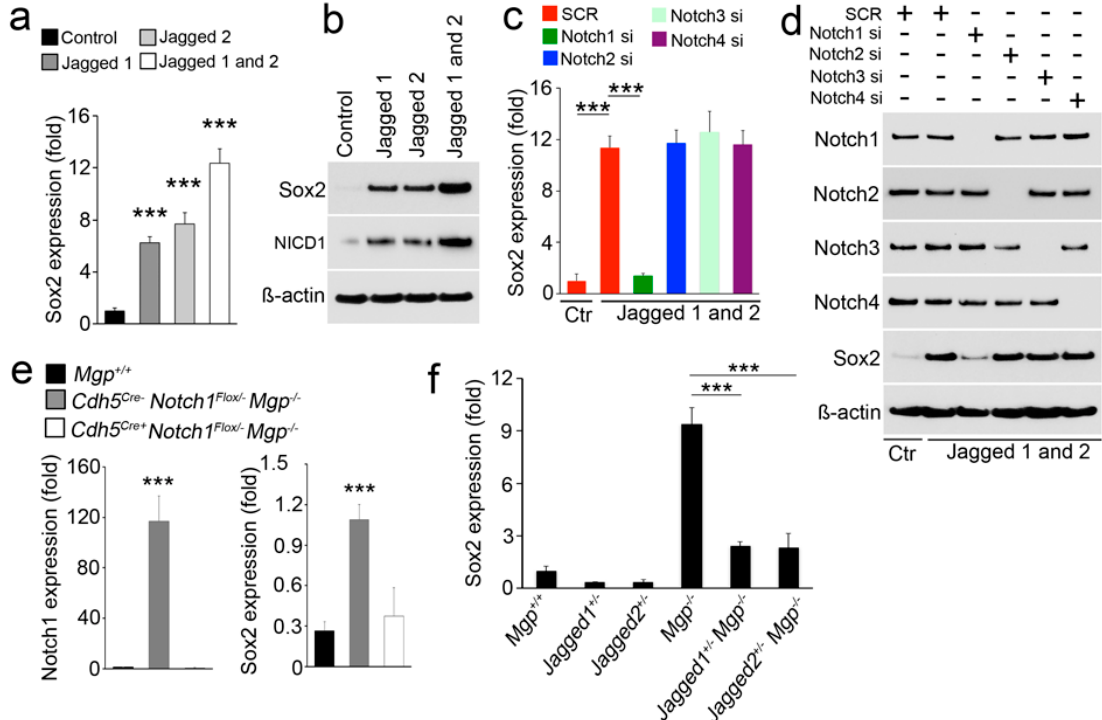
Figure 4. Excess Notch signaling induces Sox2 in cerebral ECs. ( a , b ) Sox2 expression in HBMECs treated with Jagged1, Jagged2, or their combination, as detected by real-time PCR ( a ) and immunoblotting ( b ). NICD1 was used as a control for the activation of Notch1 signaling. ( c , d ) Sox2 expression in HBMECs treated with Jagged1 and 2 after transfection with specific siRNAs (si) to Notch1, 2, 3, or 4 detected by real-time PCR ( c ) and immunoblotting ( d ). Ctr: control. ( e ) Expression of Notch1 and Sox2 in Cdh5 Cre − Notch Flox / − Mgp − / − and Cdh5 Cre + Notch Flox / − Mgp − / − cerebral ECs. Wild-type ECs ( Mgp +/+ ) were used as a control (n = 6). ( f ) Expression of Sox2 in cerebral ECs isolated from wild-type, Jagged1 +/ − , Jagged2 +/ − , Mgp − / − , Jagged1 +/ − Mgp − / − , and Jagged2 +/ − Mgp − / − mice. *** p < 0.001.